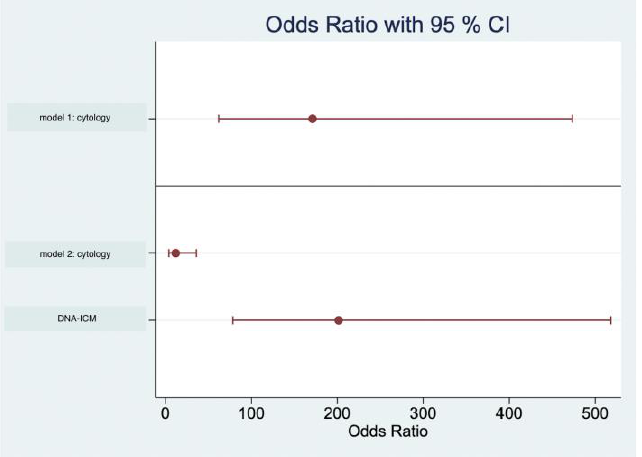
Figure 6. Model 1: calculation of the logistic regression with the cytological examination as the sole predictor (OR = 171.11). Model 2: addition of the second predictor. DNA-ICM: increased association between DNA-ICM and detection of malignant cells (OR = 201.6) in addition to decreased association for cytological examination (OR = 11.90).